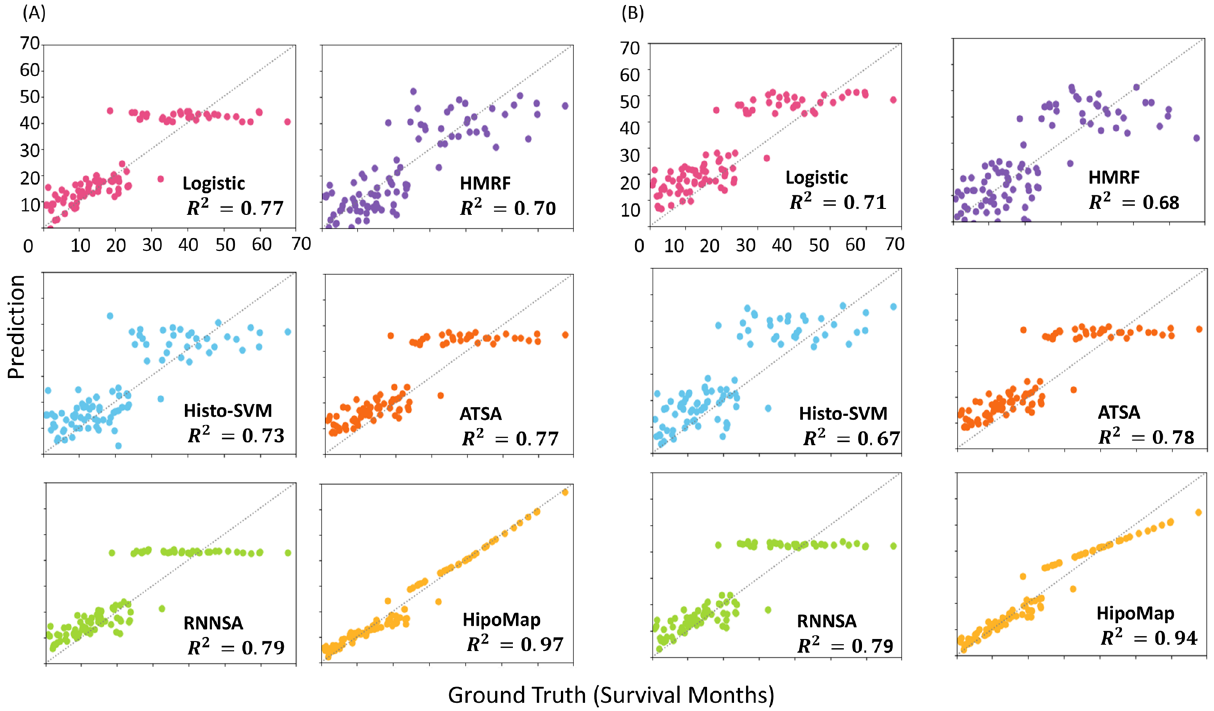
Figure 11. Survival prediction using HipoMap on 150 whole slide images in TCGA LUAD. ( A ) Results with CAT-Net as pretrain and ( B ) Results with GB as